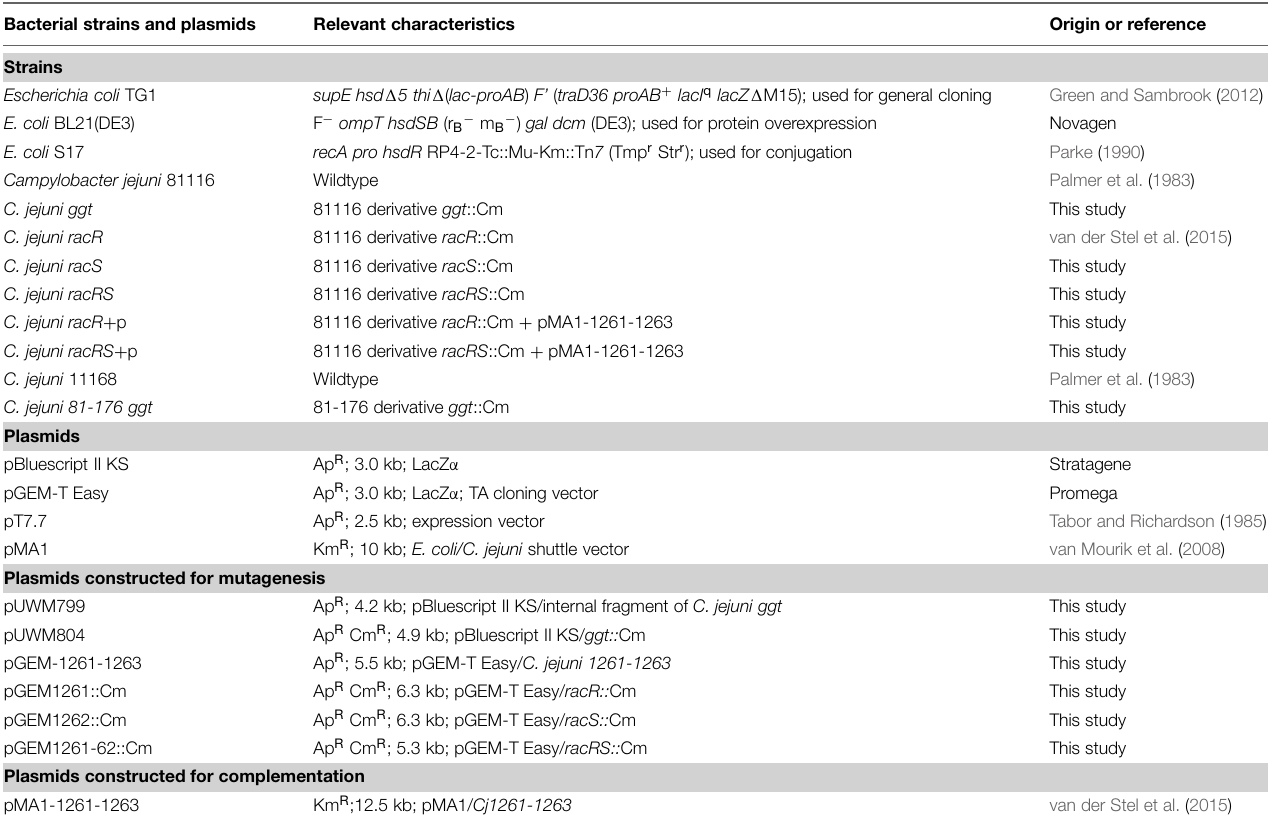
TABLE 1 | Bacterial strains and plasmids used in this